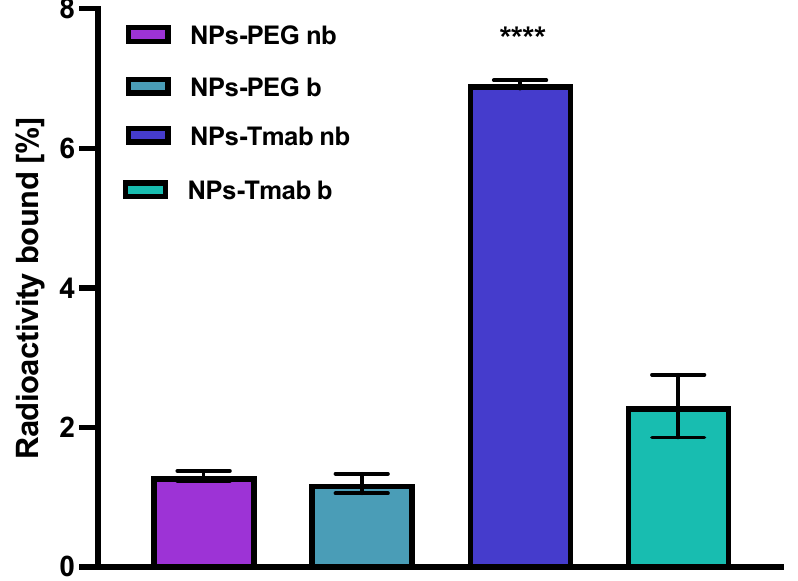
Figure 10. Specificity of binding on SKOV-3 (HER2+) of NPs-PEG and NPs-Tmab; nb—nonblocked, b—blocked with 100 molar excess of free Tmab. Data are expressed as mean value ± SD ( n = 3). Statistical confidence was considered if p < 0.0001 (****).